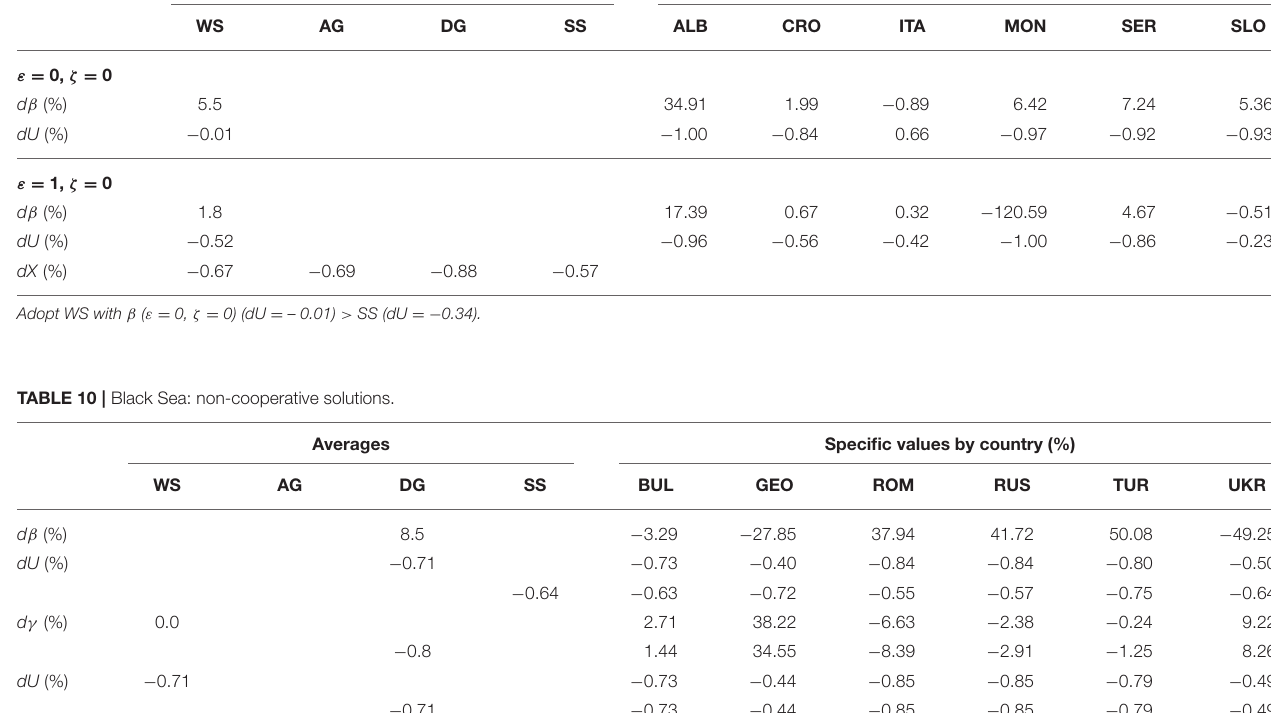
TABLE 9 | Adriatic Sea: cooperative solutions. Averages Specific values by country (%) AG SS ALB CRO ITA MON